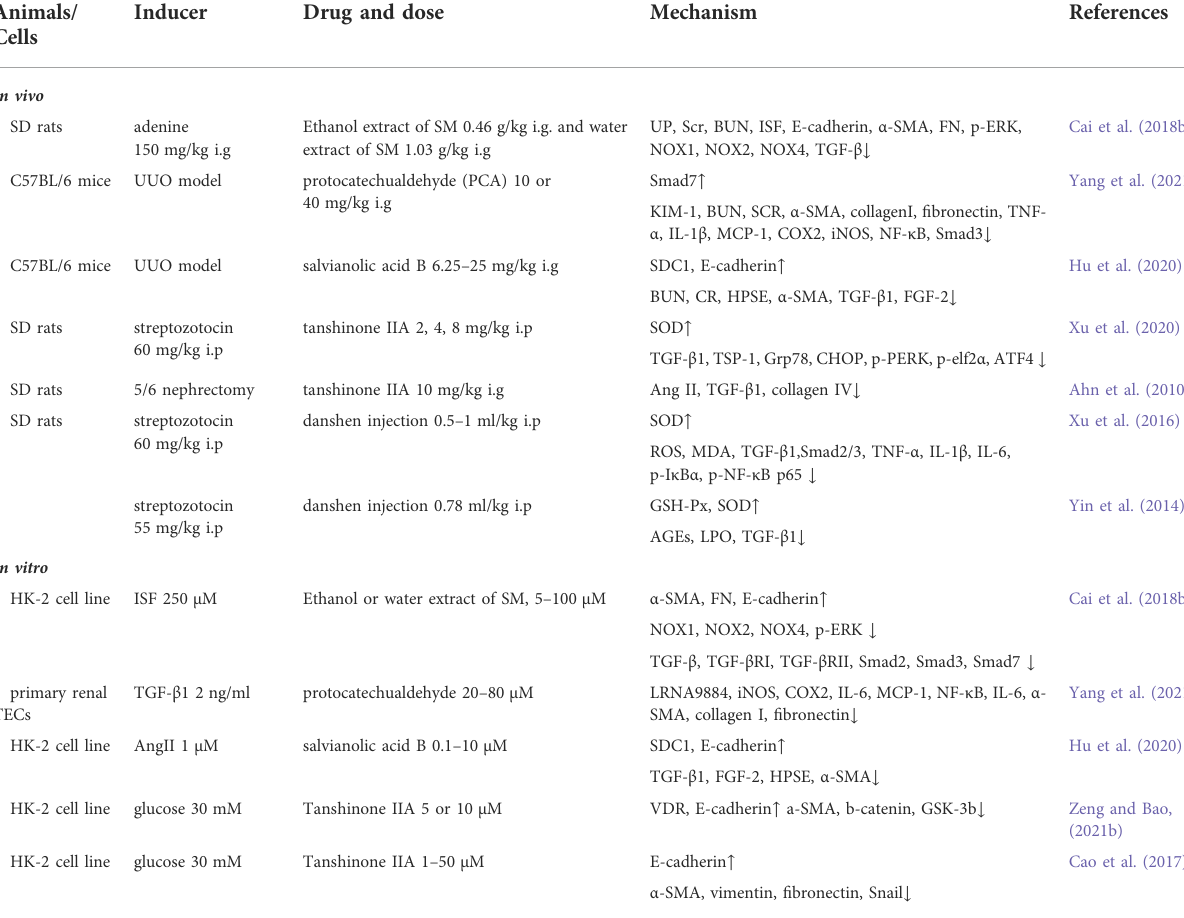
TABLE 2 Effects of SM and its active ingredients against renal fi brosis in vivo and in vitro . Animals/